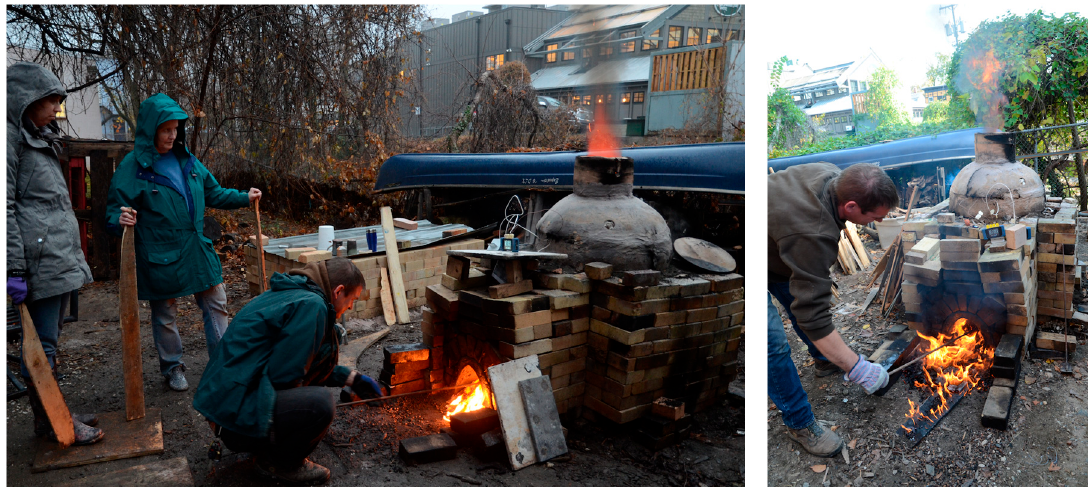
Figure 15. Raking out the reduction fuel in order to begin re-oxidation.